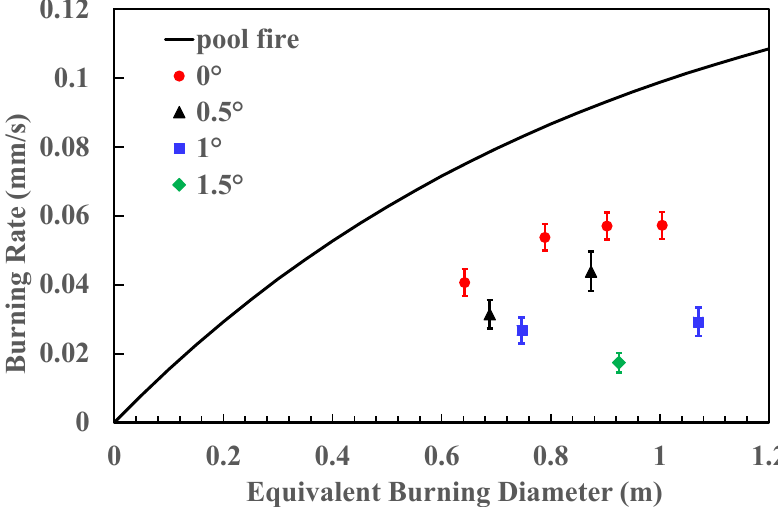
Figure 9. Comparison of burning rate between spill fires and oil pool fires.